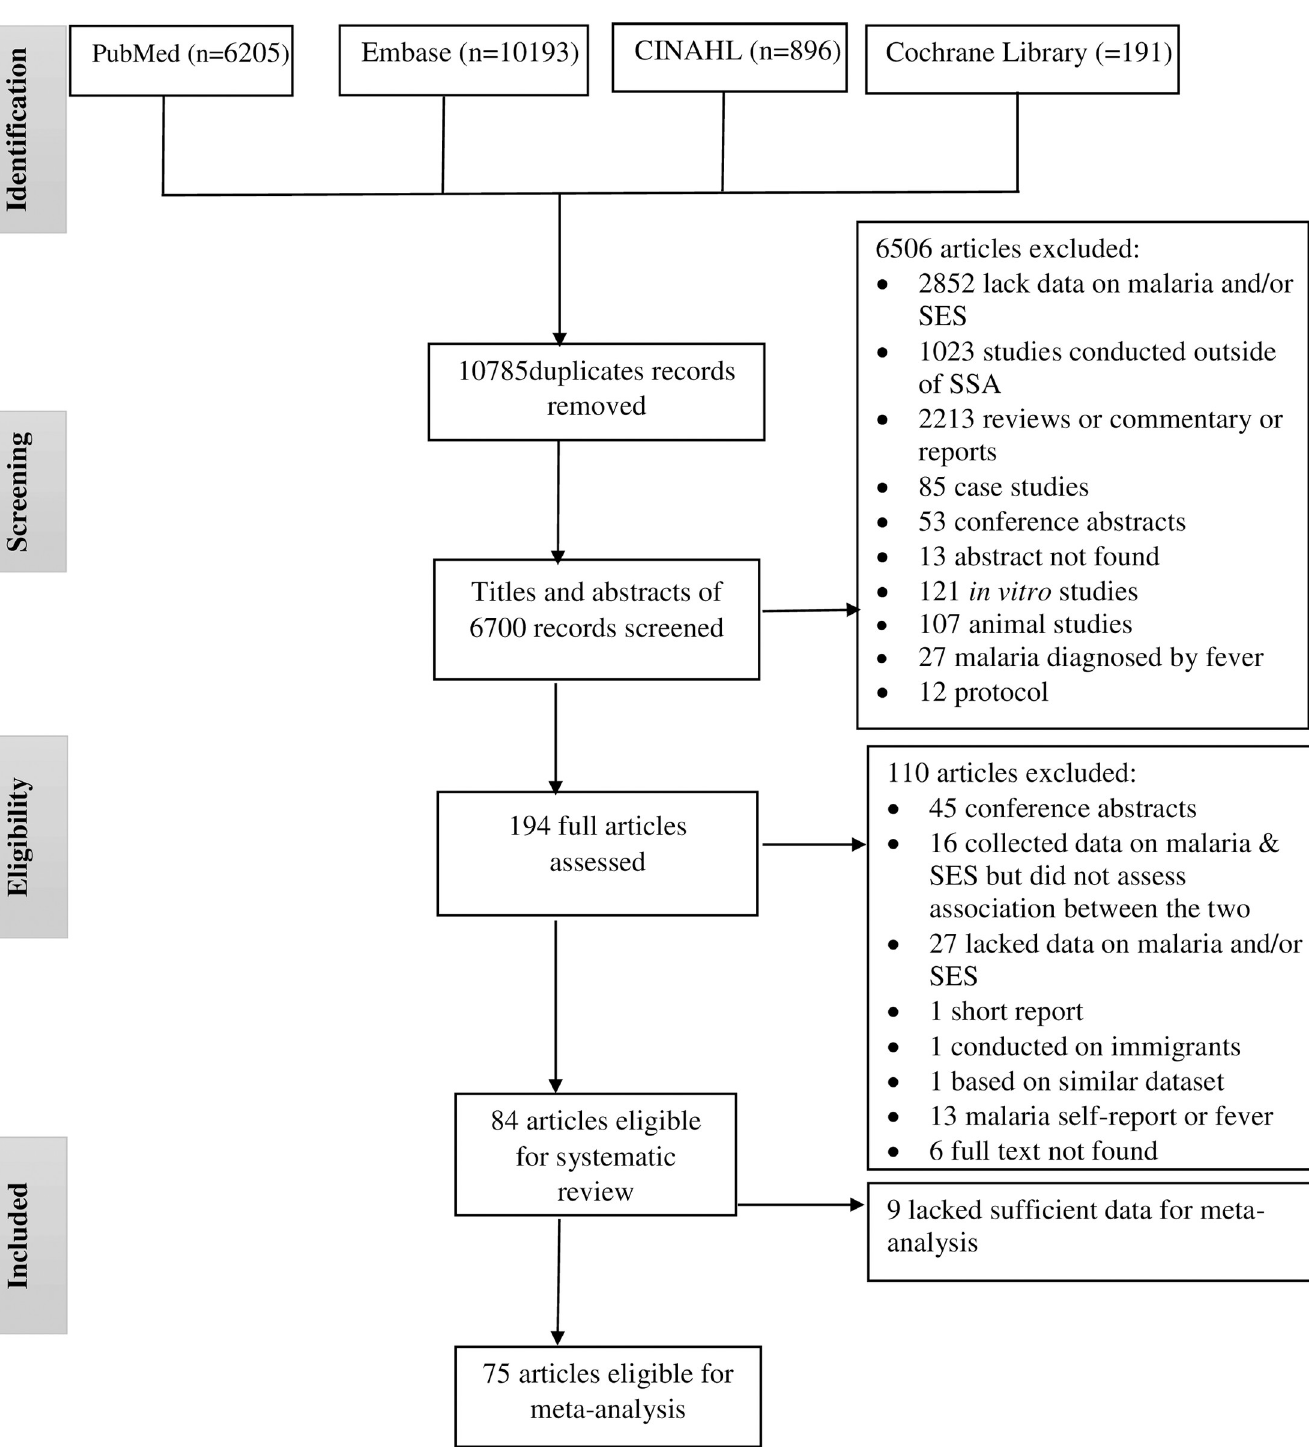
PLOS ONE | https://doi.org/10.1371/journal.pone.0211205 January 24,